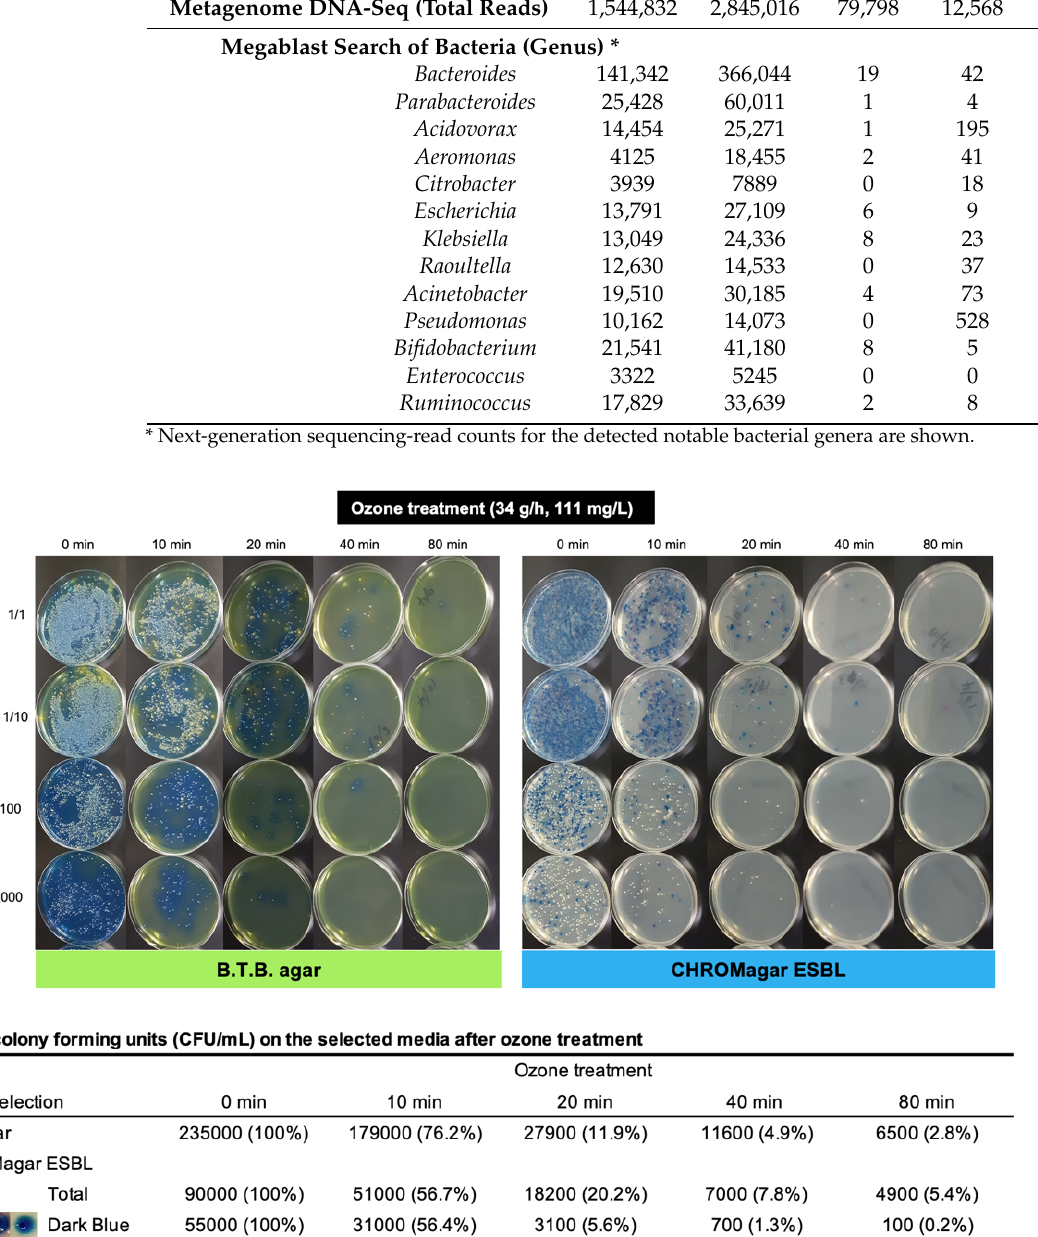
Table 1. Metagenomic DNA-seq analysis of bacteria trapped on a 0.2 µm filter after ozone treat- ment.